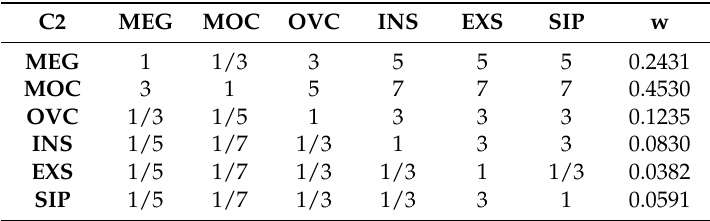
Table 5. Comparison of the six alternatives with regards to reliability (C2).